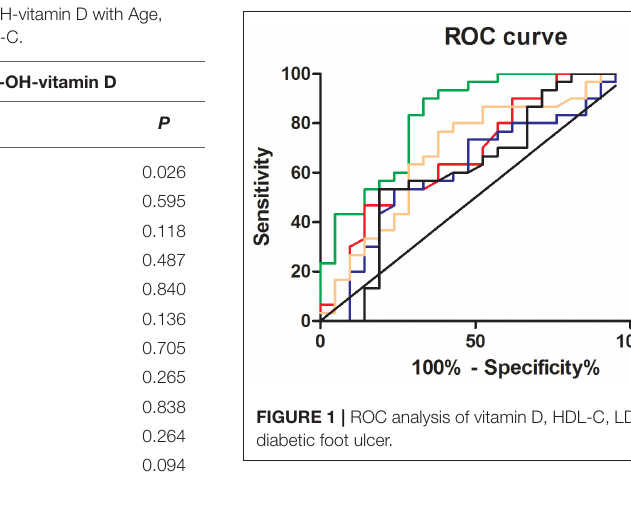
TABLE 3 | The specificity, sensitivity, best cut-off value, and the area under the curve of Vitamin D, HDL-C, and LDL-C in patients with DFU. Parameter AUC P 95% CI Cut-off value Sensitivity% Specificity% Lower